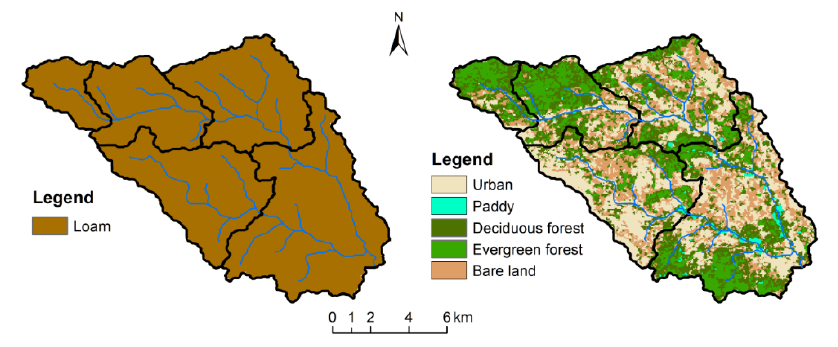
Figure 4. Soil-type and land-use profile of the Tsurumi River Basin.